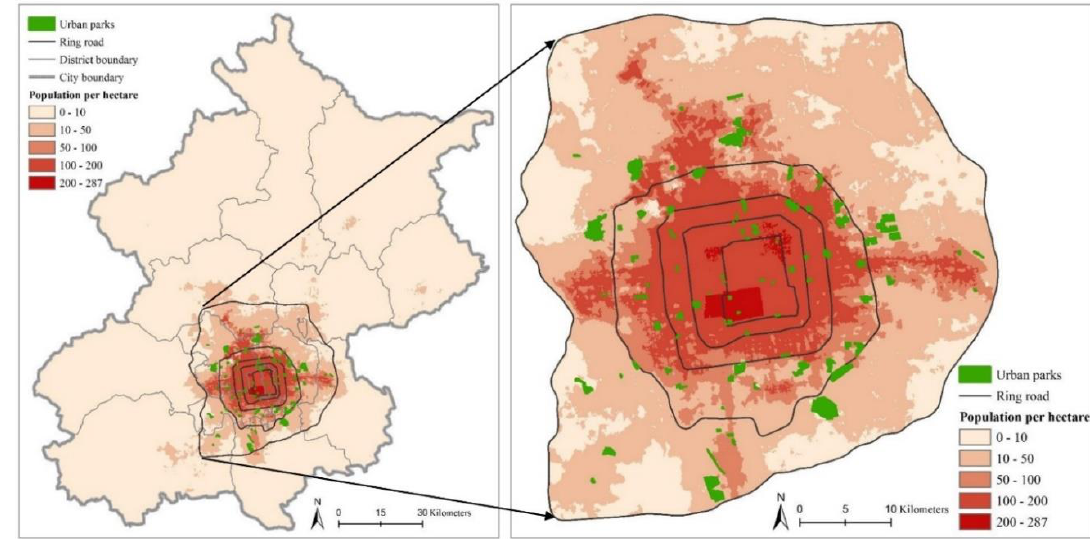
Figure 2. The spatial distribution of the urban parks and population density in the study area, from the inside to the outside, are the 2nd, 3rd, 4th, 5th, and 6th ring roads along the urban–rural gradient.